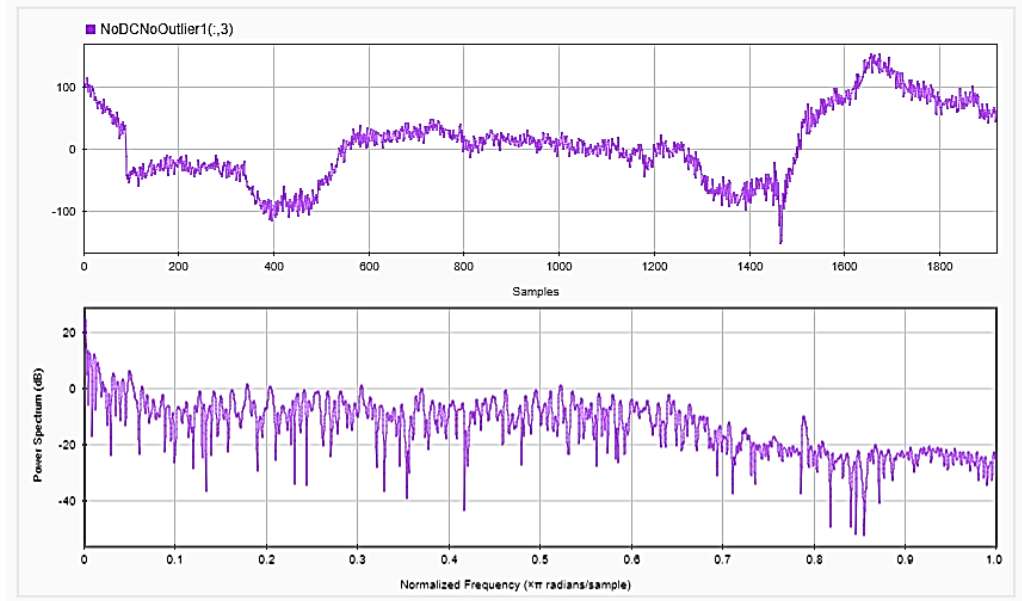
Figure 7. EEG signals for one channel after removing the DC offset and outliers in time ( upper ) and frequency ( lower ) domains.